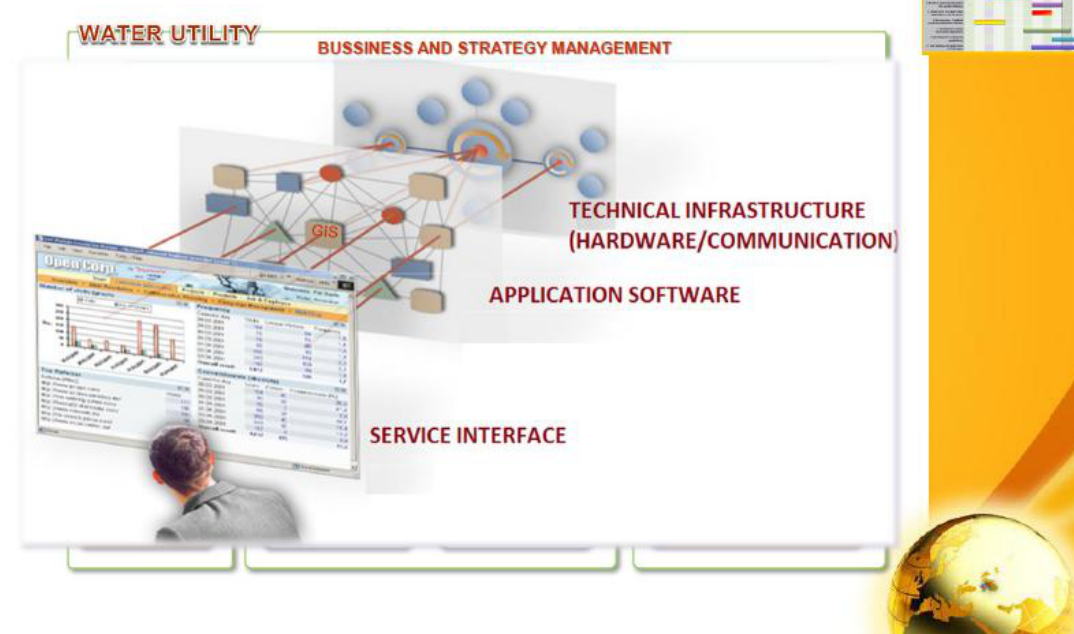
Figure 5.System Analesis of